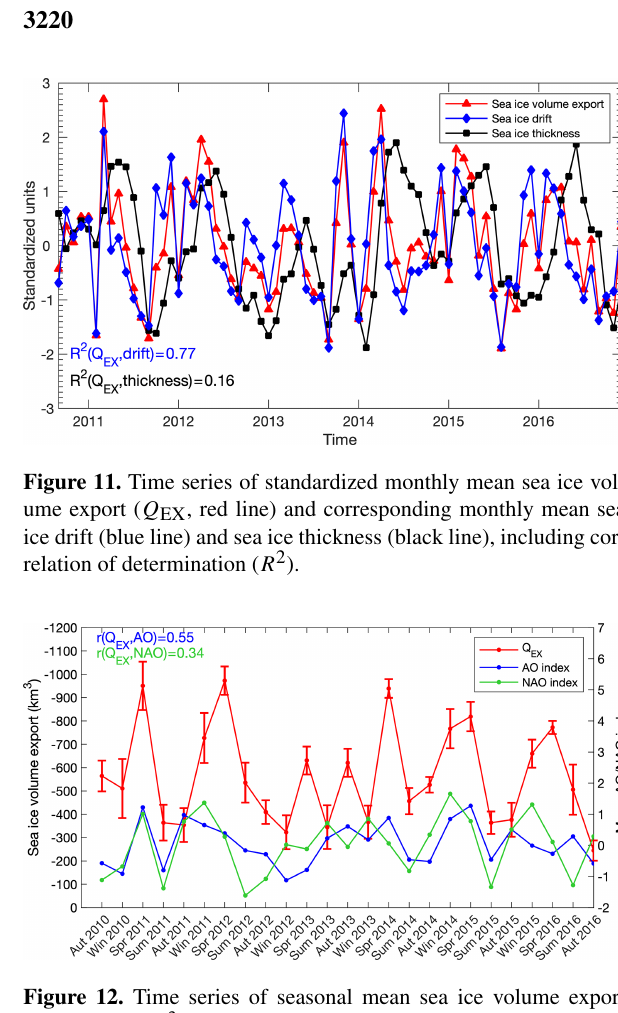
Figure 12. Time series of seasonal mean sea ice volume export ( Q EX , unit: km 3 , red line) and corresponding mean seasonal AO (blue line) and NAO (green line) index, including correlation coef- ficient ( r ).